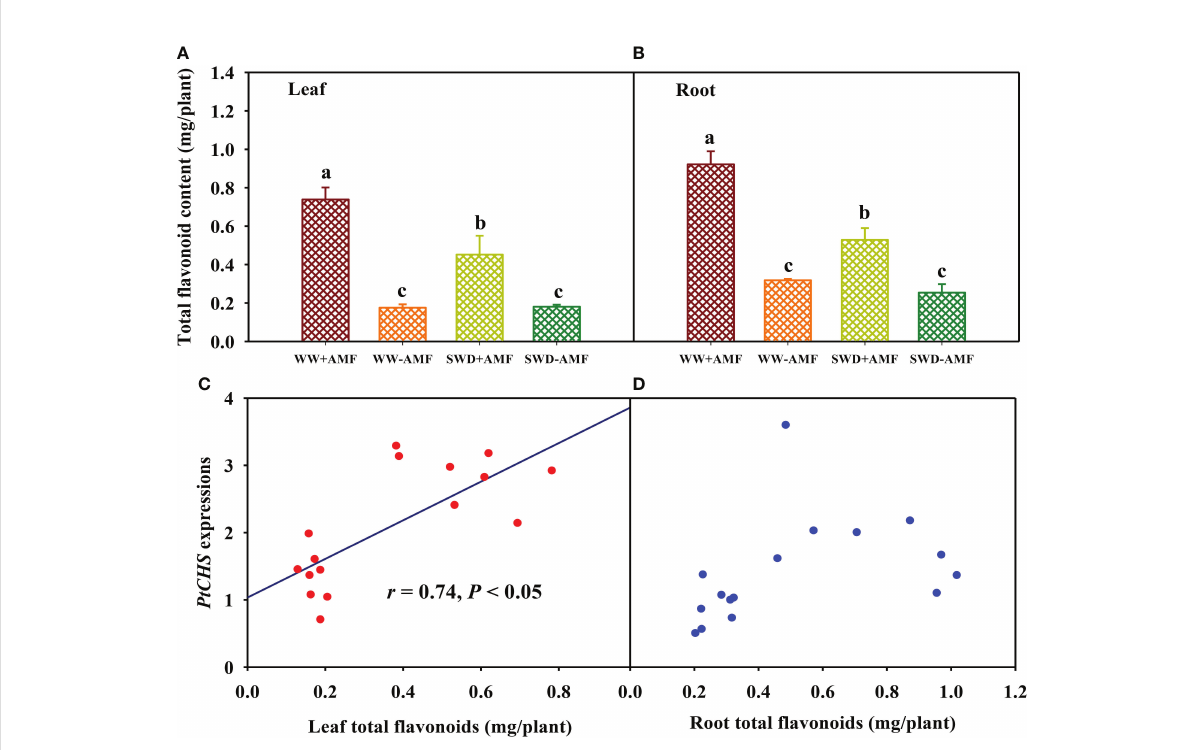
FIGURE 8 Changes in total fl avonoid content in leaf (A) and root (B) of trifoliate orange in response to soil water de fi cit and Funneliformis mosseae inoculation and their correlation with PtCHS expressions in leaf (C) and root (D) . Data (means ± SD, n = 4) followed by different letters above the bars indicate signi fi cant ( P < 0.05) differences between treatments. See Figure 5 for the